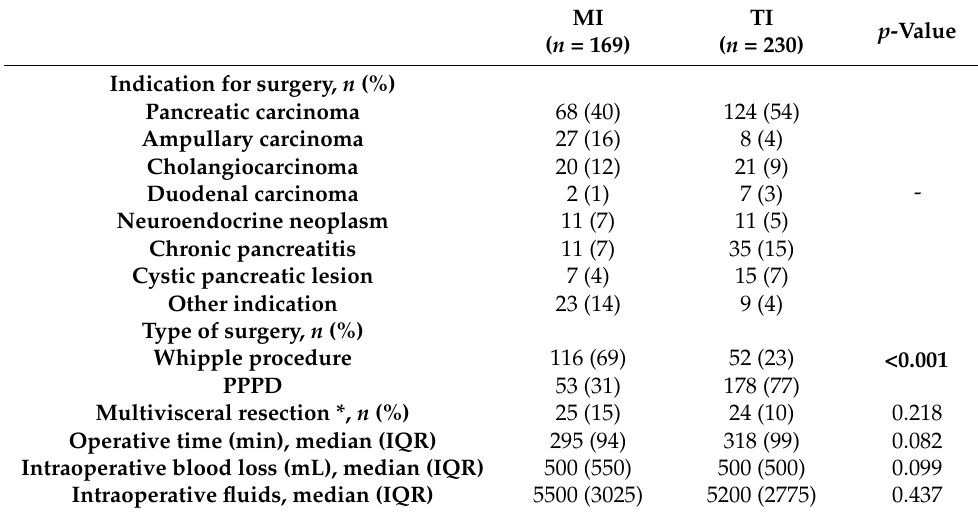
Table 2. Surgical details of patients undergoing pancreatoduodenectomy ( n = 399) stratified by incision type (MI (midline incision) vs. TI (transverse